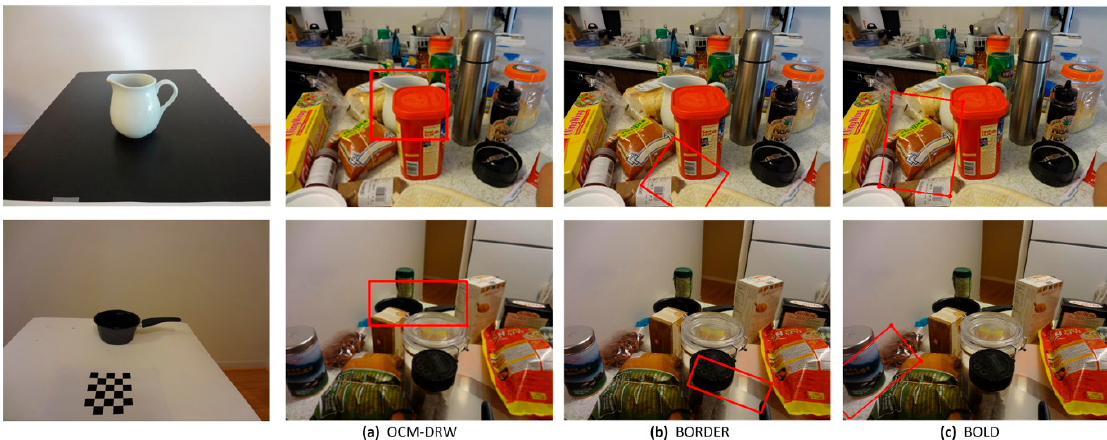
Figure 12. Some detection results are achieved by OCM-DRW, BORDER and BOLD respectively from CMU-KO8 dataset. ( a ) OCM-DRW successfully detects; ( b ) BORDER fails to detect; ( c ) BOLD also fails to detect.